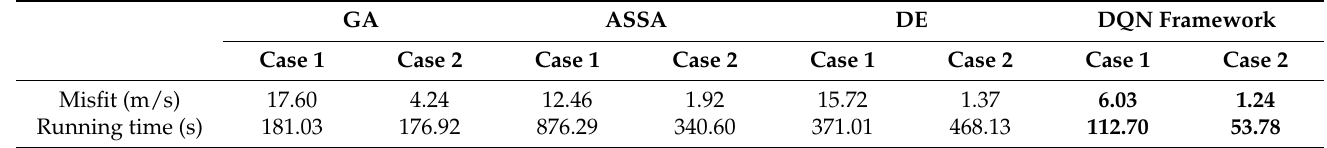
Table 9. Overall performance